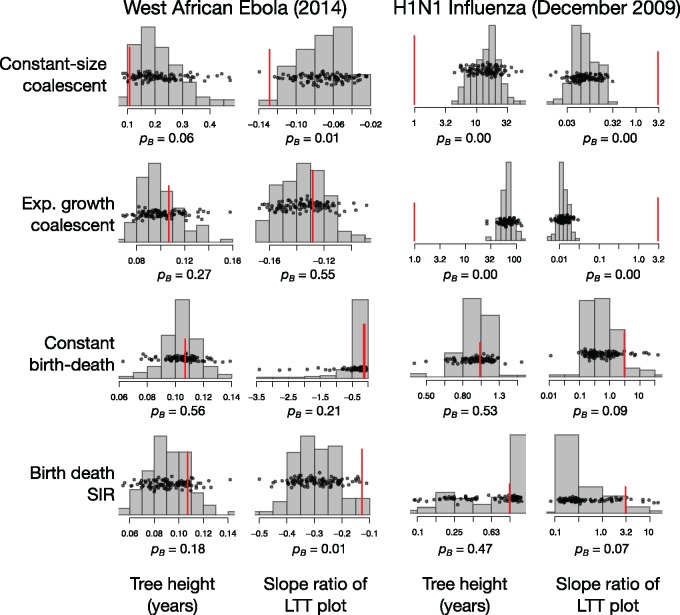
Model adequacy results for the two empirical data sets, West African Ebola, and 2009 H1N1 influenza. The histograms show the distribution of two test statistics, the tree height and the slope ratio of the LTT plot, for the posterior predictive simulations. The black points also show the distribution of the test statistics, and they have been jittered along the \documentclass[12pt]{minimal}
\usepackage{amsmath}
\usepackage{wasysym}
\usepackage{amsfonts}
\usepackage{amssymb}
\usepackage{amsbsy}
\usepackage{upgreek}
\usepackage{mathrsfs}
\setlength{\oddsidemargin}{-69pt}
\begin{document}
}{}$y$\end{document}-axis to improve visualization. The red lines denote the value for the tree estimated from the empirical data. The posterior predictive \documentclass[12pt]{minimal}
\usepackage{amsmath}
\usepackage{wasysym}
\usepackage{amsfonts}
\usepackage{amssymb}
\usepackage{amsbsy}
\usepackage{upgreek}
\usepackage{mathrsfs}
\setlength{\oddsidemargin}{-69pt}
\begin{document}
}{}$P$\end{document}-value,\documentclass[12pt]{minimal}
\usepackage{amsmath}
\usepackage{wasysym}
\usepackage{amsfonts}
\usepackage{amssymb}
\usepackage{amsbsy}
\usepackage{upgreek}
\usepackage{mathrsfs}
\setlength{\oddsidemargin}{-69pt}
\begin{document}
}{}$ P_{B}$\end{document}, is shown for each test statistic. A feature of the empirical phylogenetic tree described by a test statistic, such as the tree height, is considered adequately described by the model if the empirical value falls within the 95% quantile range of the posterior predictive distribution, such that the \documentclass[12pt]{minimal}
\usepackage{amsmath}
\usepackage{wasysym}
\usepackage{amsfonts}
\usepackage{amssymb}
\usepackage{amsbsy}
\usepackage{upgreek}
\usepackage{mathrsfs}
\setlength{\oddsidemargin}{-69pt}
\begin{document}
}{}$P_{B} $\end{document}>0.05. Two more test statistics were computed, the ratio of external to internal branch lengths and the Colless index, which are shown in Supplementary Fig. S1 available on Dryad. Note that for the H1N1 influenza analyses, the values are shown in a log\documentclass[12pt]{minimal}
\usepackage{amsmath}
\usepackage{wasysym}
\usepackage{amsfonts}
\usepackage{amssymb}
\usepackage{amsbsy}
\usepackage{upgreek}
\usepackage{mathrsfs}
\setlength{\oddsidemargin}{-69pt}
\begin{document}
}{}$_{\mathrm{10}}$\end{document} scale.